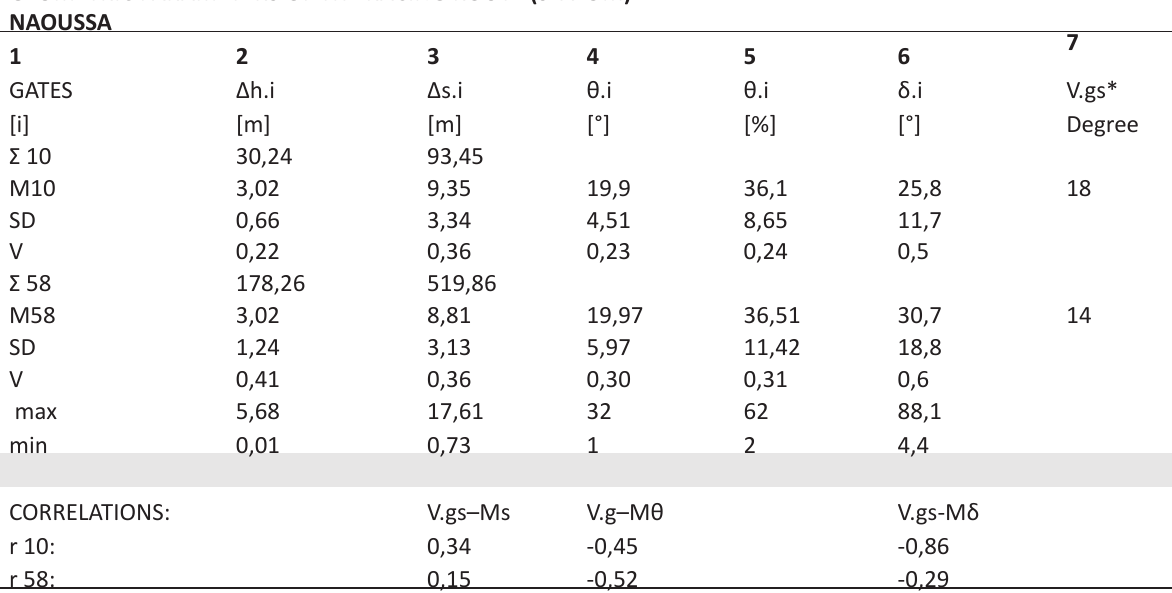
Table 1. The aggregated results of the parameters and the coefficients of geometry of slalom in Naoussa in 10 gates and 58 gates: h - height from the finish line, Δh - altitude difference, s - distance Δs - distance difference, θ - angle of terrain slope, δ - deviation angle of the